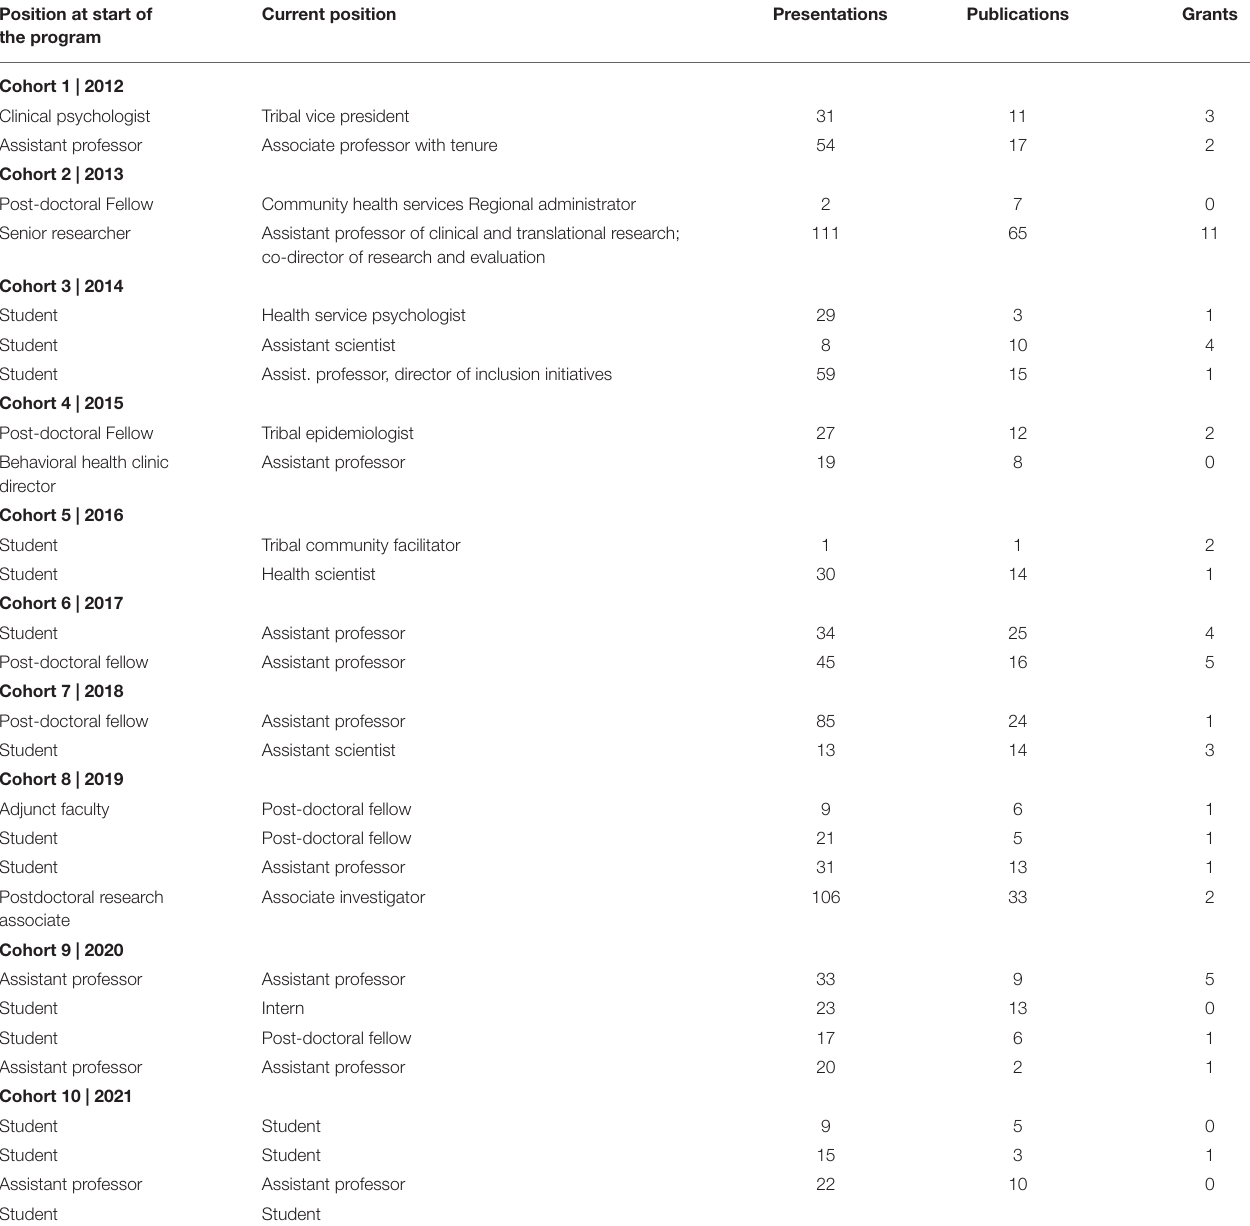
TABLE 1 | Metrics of the progress of NCRE Scholars in Cohorts 1-10. Position at start of the